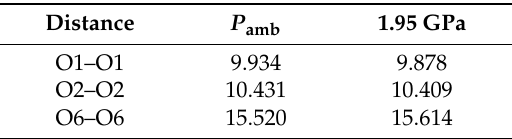
Table 3. Calculated average diameters of 12 MR channel in Å from room-temperature FPMD simulations at different compression for the hydrated ZL/1.5FL